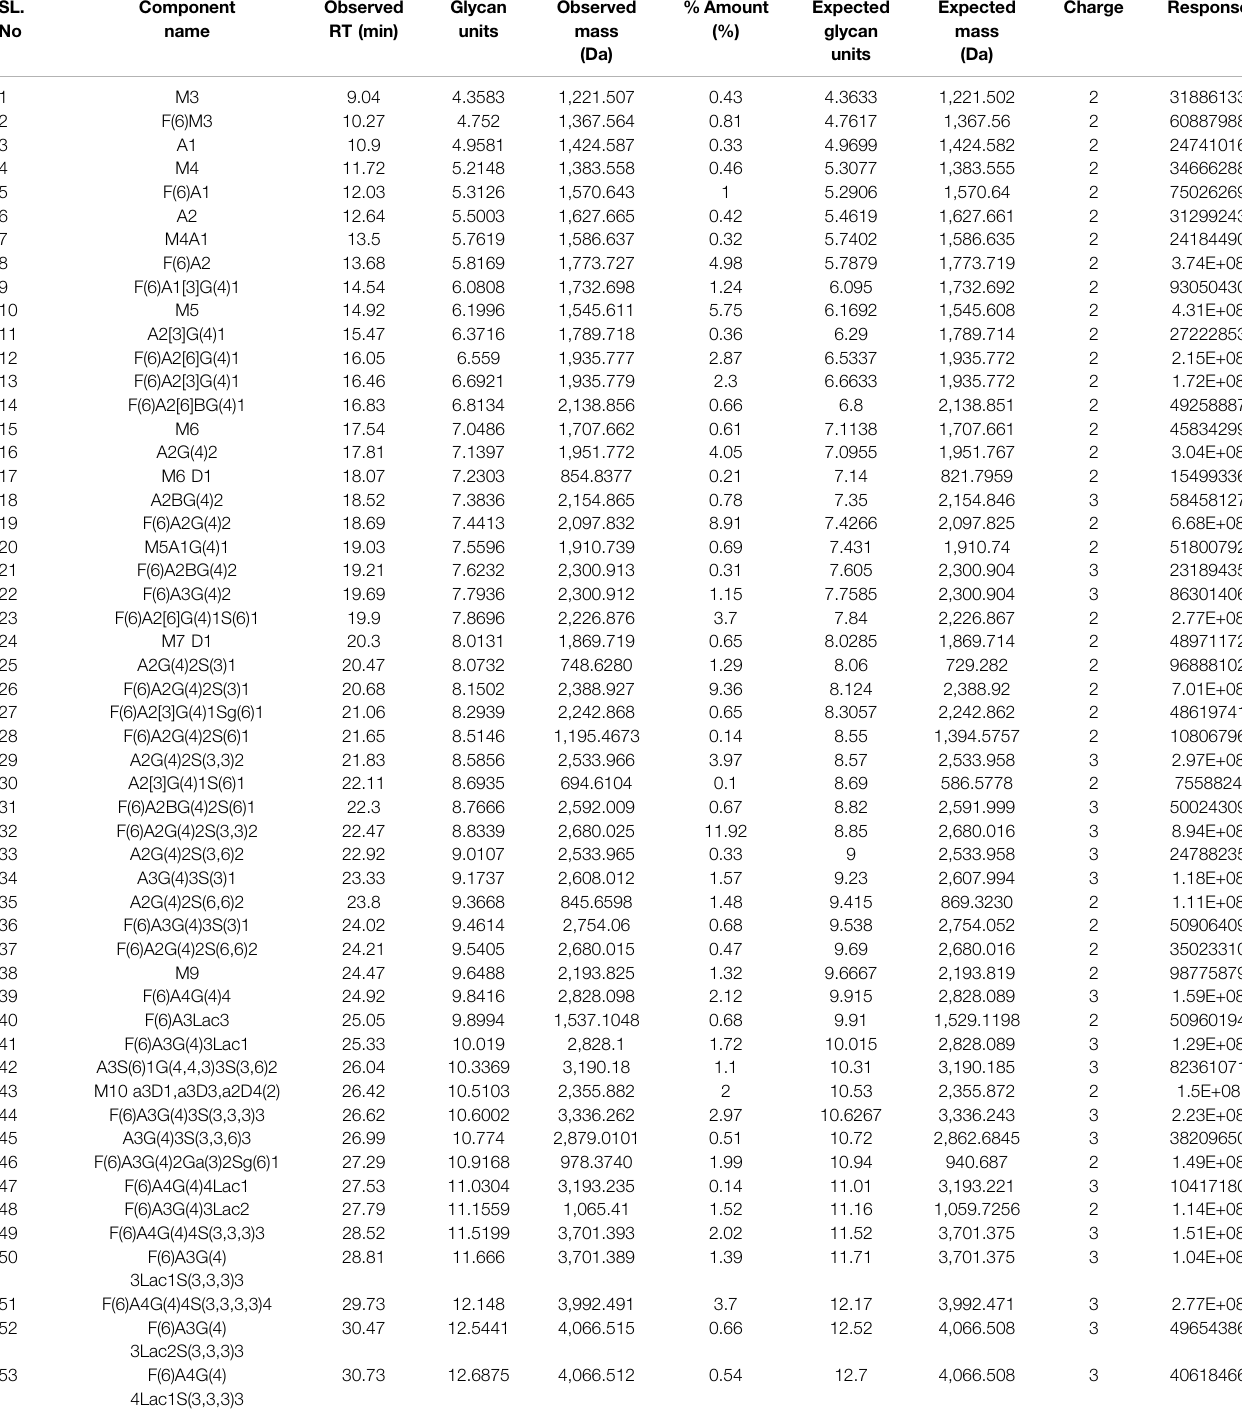
TABLE 1 | List of the con fi rmed N-glycans derived from VRC01 mAb analyzed in the study. Also included are the observed retention times, normalized abundance (% amount),expectedandobservedGUvalues,expectedandobservedmasses,thepredominantchargestate,andtheresponseunits.Thehighlightedglycanspeciesare those that are shortlisted to be monitored using the screening work fl